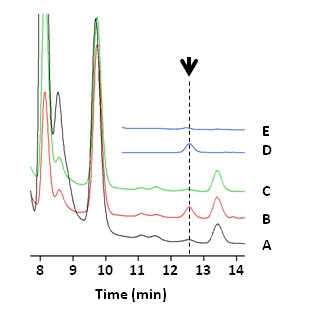
Formate production by pAM505-fdh exoconjugant cyanobacteria.The wild-type and exoconjugant 
Anabaena
 cultures (BG11, OD700 ~3) were inoculated into BG110 and cultivated for 36 h under a light of 15 µmol photon m-2 s-1 and under air atmosphere. The media were then degassed and bubbled with argon + 10% CO2 for 12 h under a light of 150 µmol photon m-2 s-1. The cells anaerobically harvested were homogenized in 1N HCl. The resulting lysate was analyzed by ion-chromatography and the chromatograms of 
Anabaena
-WT (A) and 
Anabaena
-fdh (B) are shown. The lysate of 
Anabaena
-fdh was also treated with 

Candida

boidinii
 FDH (Sigma-Aldrich, Missouri, USA) and NAD+ overnight and was then analyzed (C). The chromatograms of formate solutions without and with the treatment with 

Candida

boidinii
 FDH and NAD+ are shown as controls (D and E, respectively).